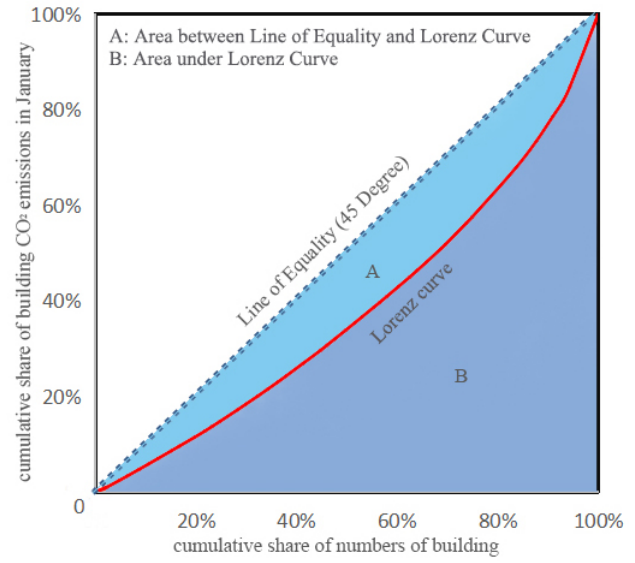
Figure 10. Lorenz curve for CO 2 emission quota allocation in January.